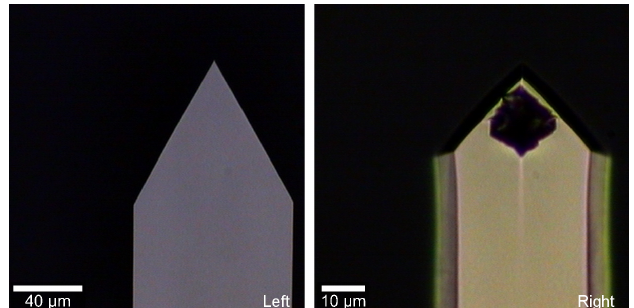
Figure 6. Calibrated images of the end of the cantilevers. ( Left ) Arrow TL1 cantilever; ( Right ) MikroMasch